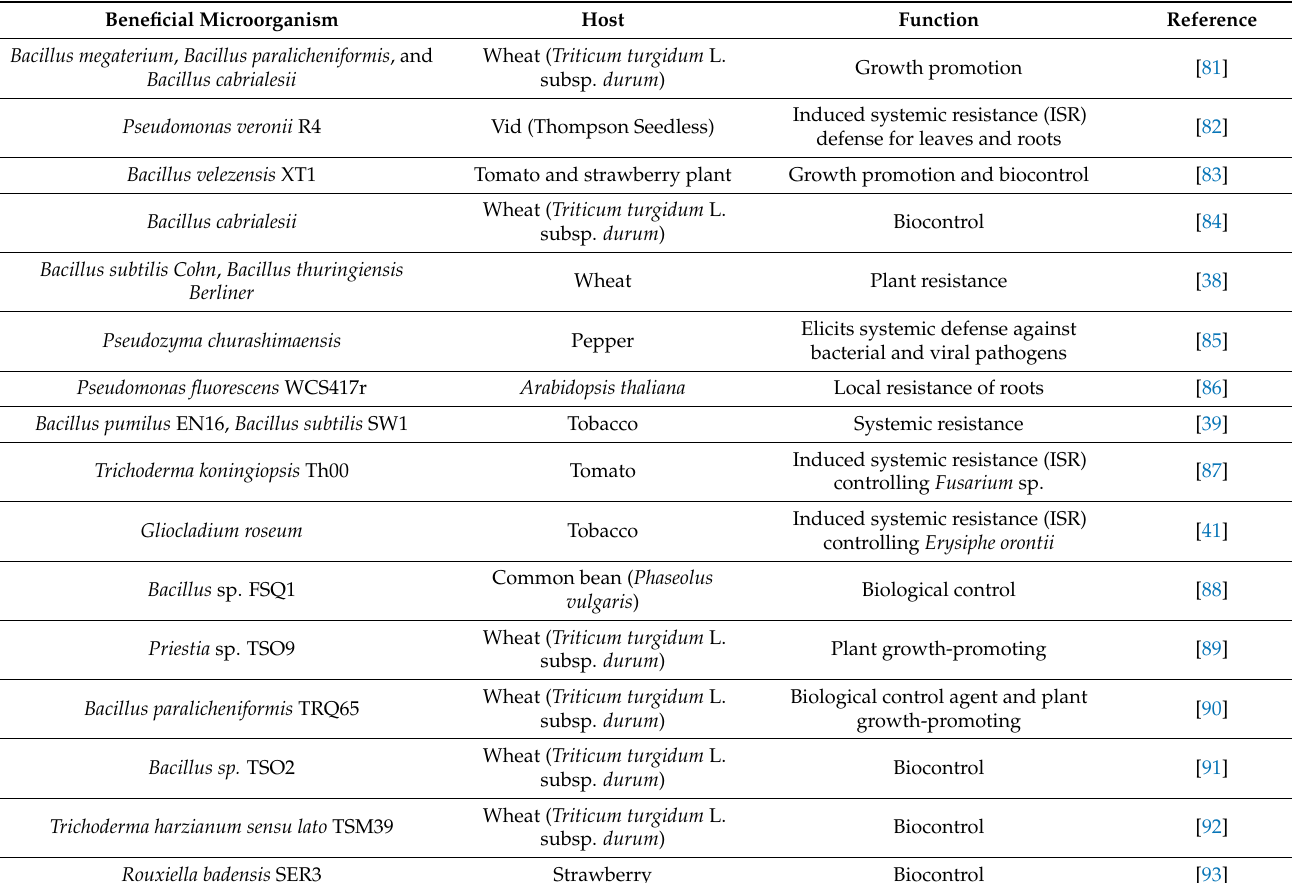
Table 2. Beneficial microorganisms for